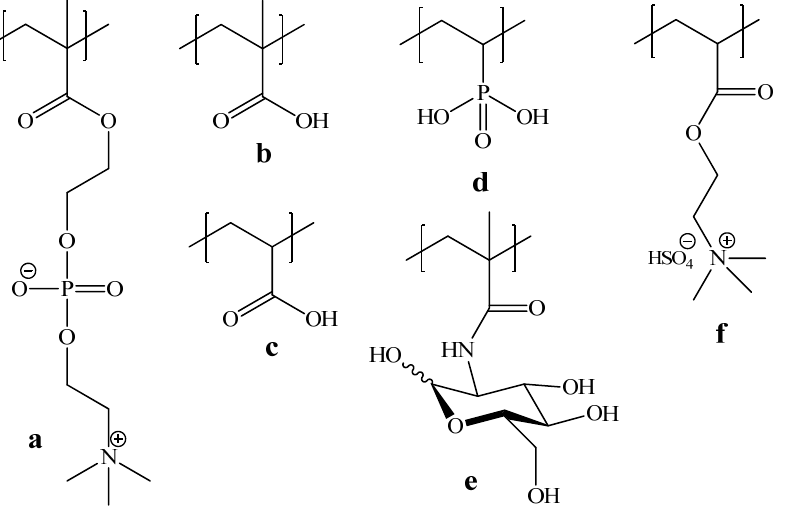
Table 1 gives characteristics of the polymers used in the present work: their molecular masses, copolymer compositions (the subscript shows the mole percent of ionized groups); for luminescent-labeled (co)polymers, a quantity of (co)polymer units per 1 luminescent marker is